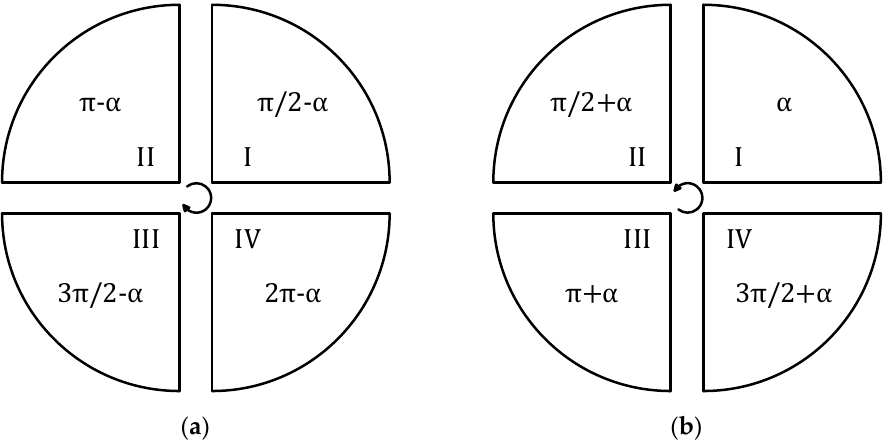
Figure 15. Changing the starting point of an arc (with an accuracy of 90°): ( a ) Clockwise motion and ( b ) counter clockwise motion.